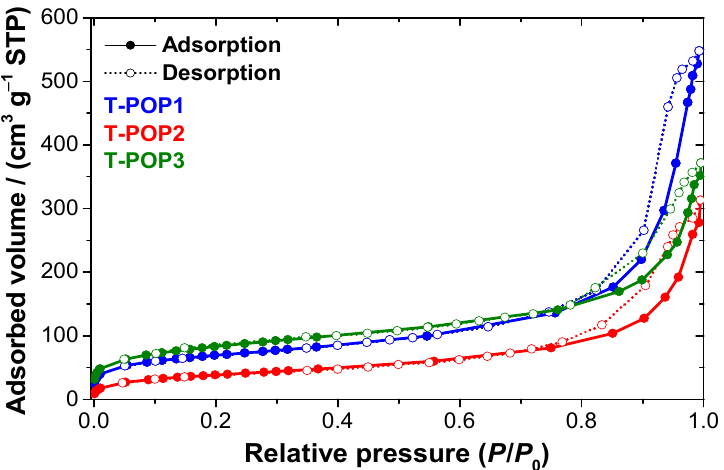
Figure 5. N 2 adsorption–desorption isotherms of T-POP1, T-POP2, and T-POP3. The parameters obtained by N 2 sorption, DLS, and ζ -potential analysis are described in Table 1. For the average pore diameter ( d p ), the tendency d p (T-POP3) < d p (T-POP2) < d p (T-POP1) was observed, and the smaller pores of T-POP2 and T-POP3 may be related to the structure of the selected starting aldehyde, since dialdehydes EDP and DHA, when compared to terephthalaldehyde (T-POP1), present more functional groups, and its reactive formyl groups appear closer to each other. Additionally, the tightest pore of T-POP3 can also result from the interaction between carboxylic acid groups and adjacent amine groups to form a R 2 NH 2 + COO −